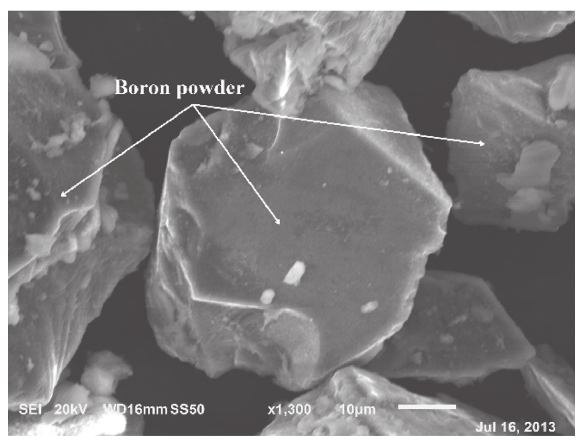
Figure 2: SEM image of particles boron powder mixture.